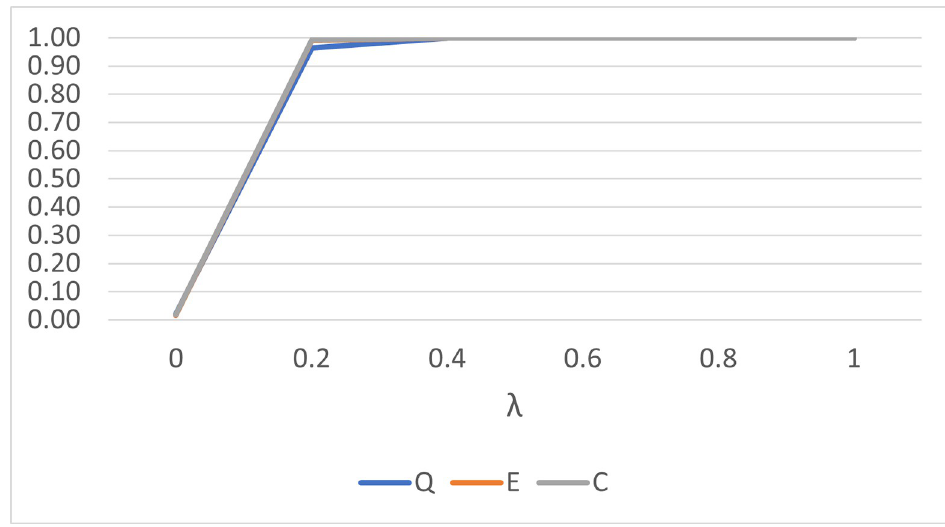
Fig 4. The performance of the Q k , E k and C k statistics for n = 30 and κ = 50, for a patch of three outliers. https://doi.org/10.1371/journal.pone.0273144.g004 concentration parameter ^ k ¼ 17 : 9100 . The spherical plot of the data is given in Fig 5. The samples are located around a north pole. This indicates that both variables, namely the poste- rior and angle of the eye, recorded these 23 observations to be in the same direction. However, there is one observation lying further away from the rest. It is known that Q-Q plot and probability plotting are commonly used to investigate the goodness of fit of linear, circular and spherical data samples (see for example [14–16]). It is used to visualize the goodness of fit and to identify the presence of outlier(s) at earlier stage [11]. Provided procedures of plotting an ordered value for spherical data which is assumed to follow a Fisher distribution. They proposed three types of procedures, namely, colatitudes, lon- gitude and two-variable plotting procedure for a Fisher model. The procedures considered three-ordered-value plots. Two of them examine the marginal distributions of the two vari- ables and one of them is to find the association between these two variables. The details of the procedures can be obtained in [11]. Note that, the quantile of the unit exponential distribution